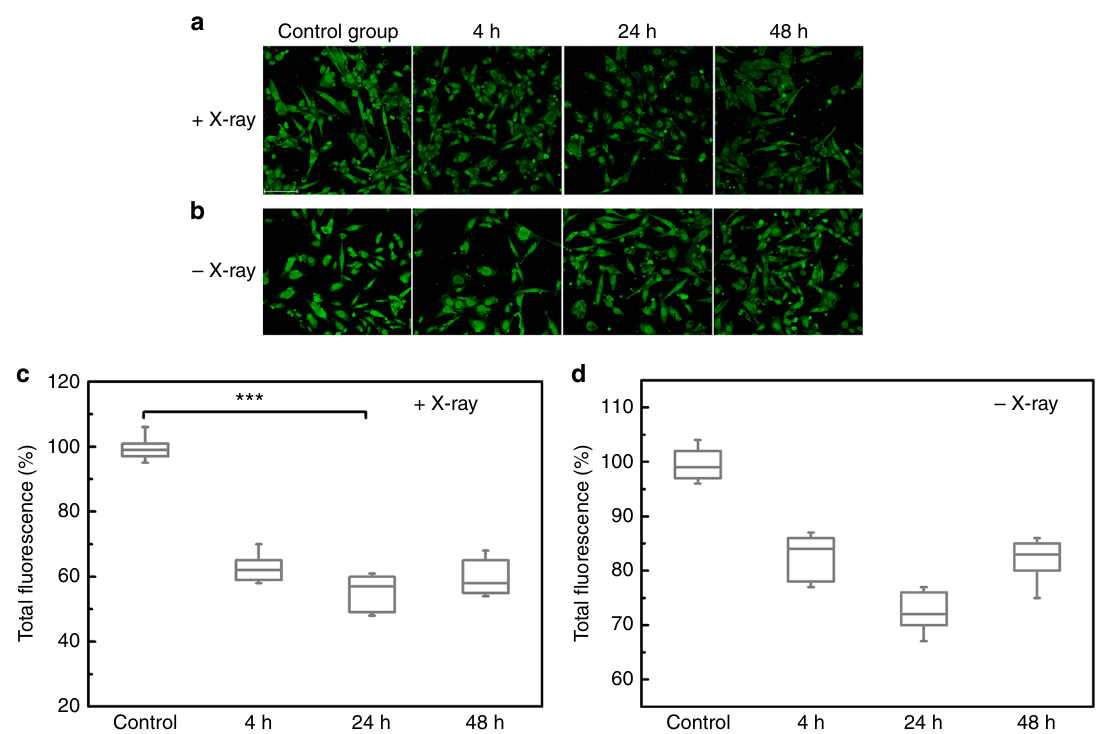
Fig. 5 In vitro gene silencing by X-ray triggered liposomes loaded with antisense oligonucleotide. a , b Representative confocal images of indirect immuno fl uorescence staining of PAC1R at different time points after cells were treated with ( a ) X-ray-triggered liposomes and ( b ) liposomes alone. The concentration of liposomes incubated with cells was 25 µ M. Scale bar was 75 µ m. Boxplots in c , d show quantitative assessment of PAC1R gene silencing induced by antisense oligonucleotide released from liposomes at different time points ( c ) with and ( d ) without X-ray radiation. Decreased PAC1R fl uorescence intensity was expressed as percentage of the control. The box is bounded by the fi rst and third quartile with a horizontal line at the median and whiskers extend to 1.5 times the interquartile range. The mean value was analysed using the t test ( n = 5). *** P < 0.001, compared with the